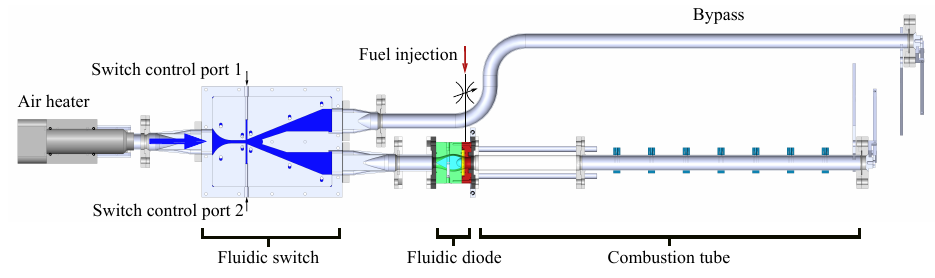
Figure 2. Schematic of the atmospheric SEC test rig.